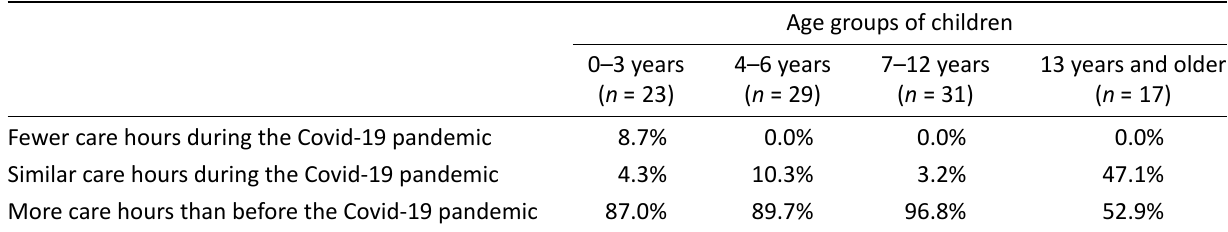
Table 2. Changes in care hours during the pandemic in relation to the age of children living in the household.